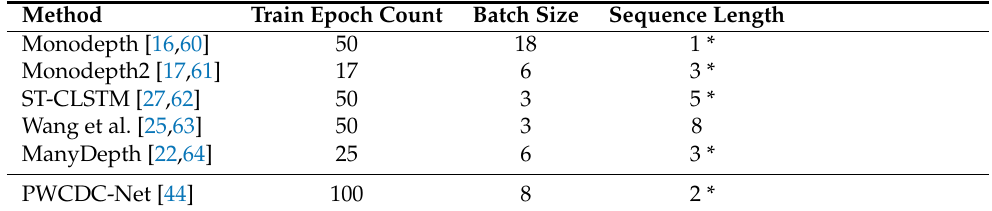
Table A1. Main parameters used to train baseline methods. The asterisk denotes default parameters suggested by authors for their respective